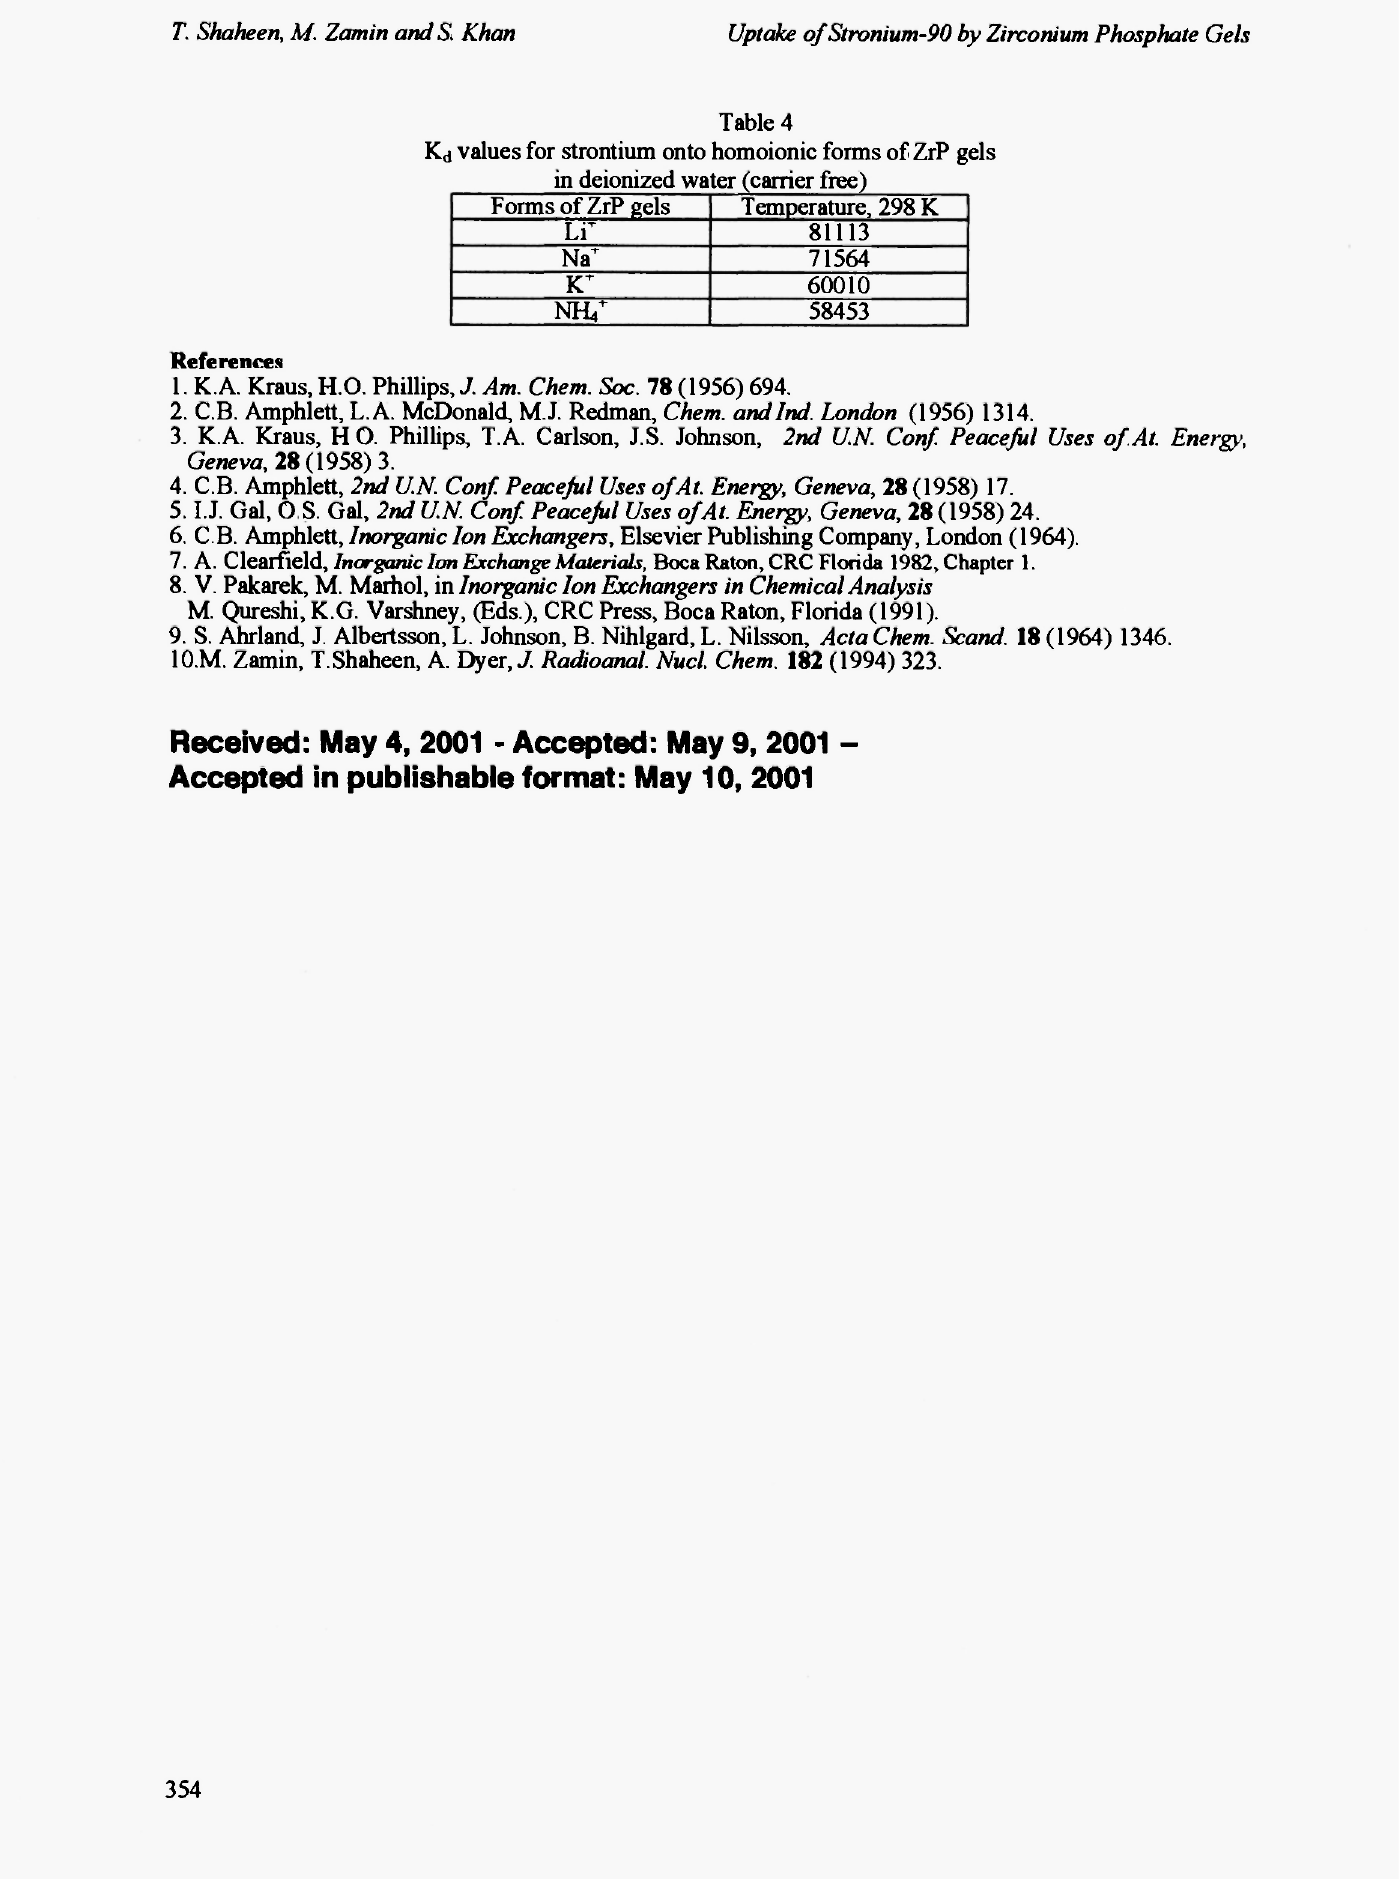
K d values for strontium onto homoionic forms of ZrP